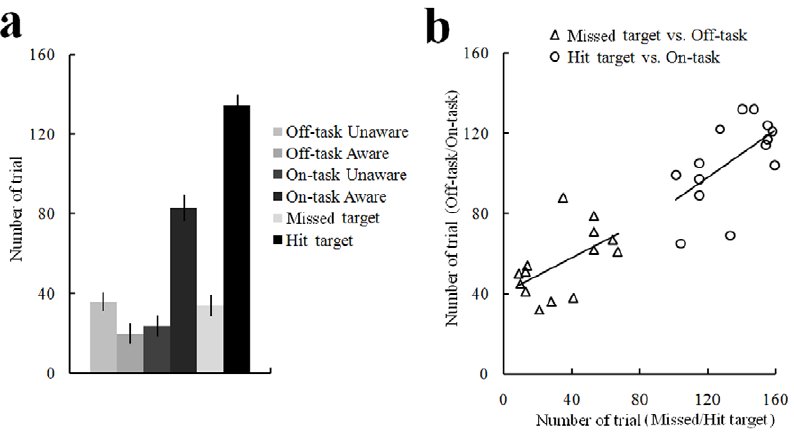
Figure 1. Behavioral results. (a) Trial number under each condition, error bars indicate standard errors of the mean; (b) Positive correlation between trial number of off-task and trial number of missed target, and positive correlation between trial number of on-task and trial number of hit target. The data of each subject is indicated by a triangle or circle. The lines represent the linear best fit.